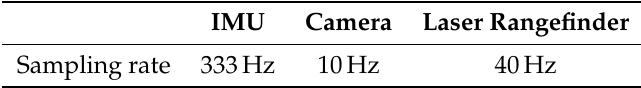
Table 4. Sampling rates of the sensors